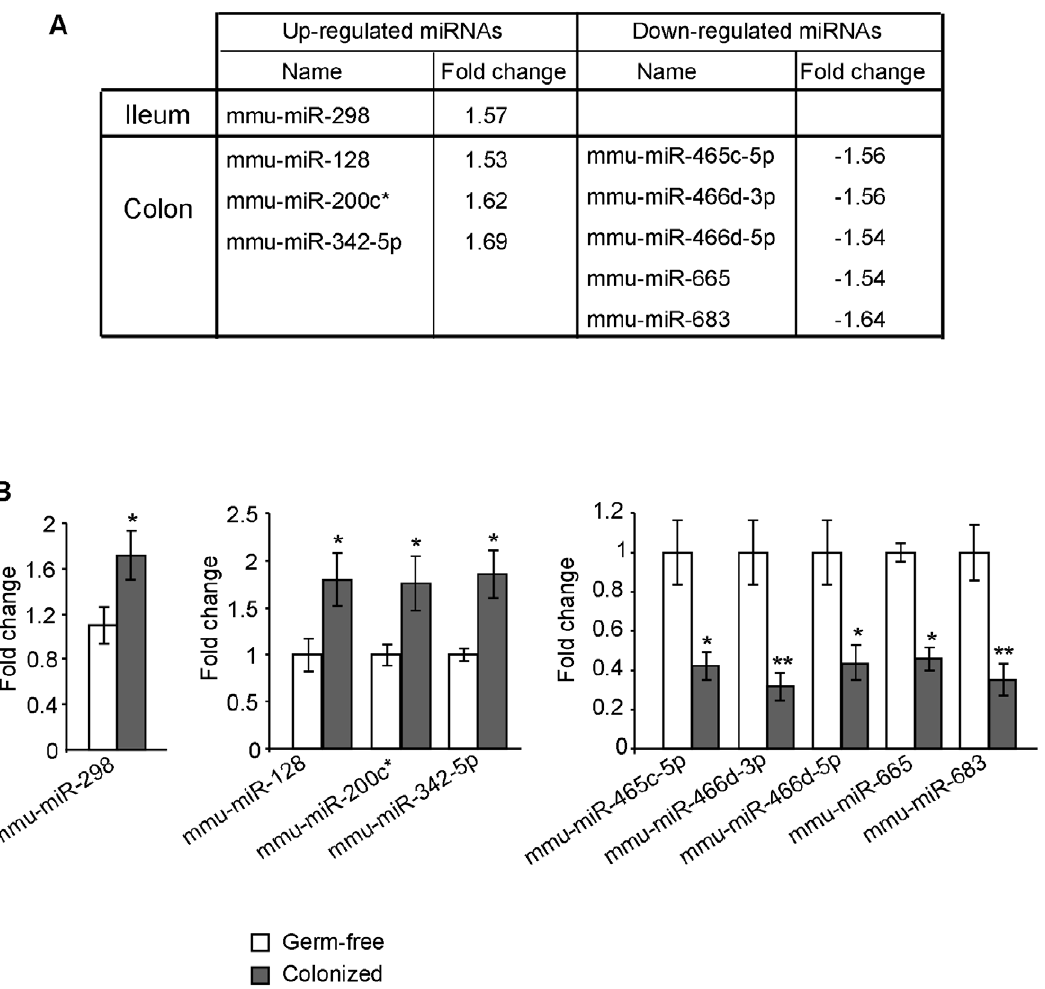
Figure 1. Microbiota modulate host miRNA expression. Germ-free mice were colonized with the microbiota from pathogen-free mice. Total RNAs were extracted from the ileums and colons of germ-free and colonized mice. MiRNAs differentially expressed in the ileum and colon of colonized mice compared to germ-free mice ( $ 1.5-fold) determined by miRNA array (A) and qRT-PCR (B). Values represent means 6 S.E.M. (n=6/ group; * P , 0.05; ** P ,